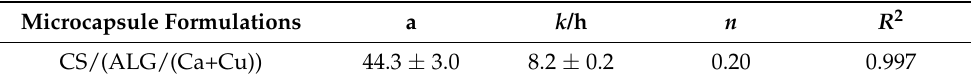
Table 6. Values of the constant ( k ), exponent ( n ), and correlation coefficient ( R 2 ) of Cu(II) complex released from (CS/(ALG/(Ca+Cu)) microcapsule. Microcapsule